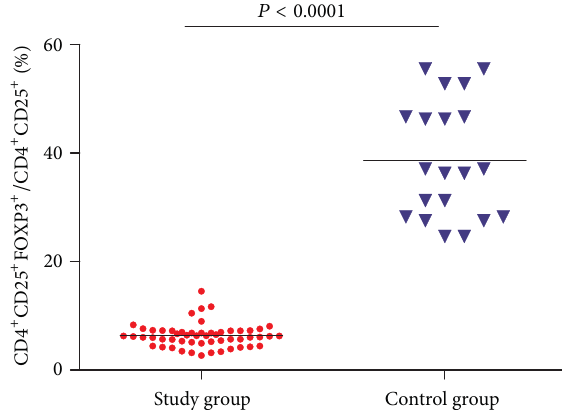
+ CD25 + FOXP3 + /CD4 + CD25 + (%) in study and control